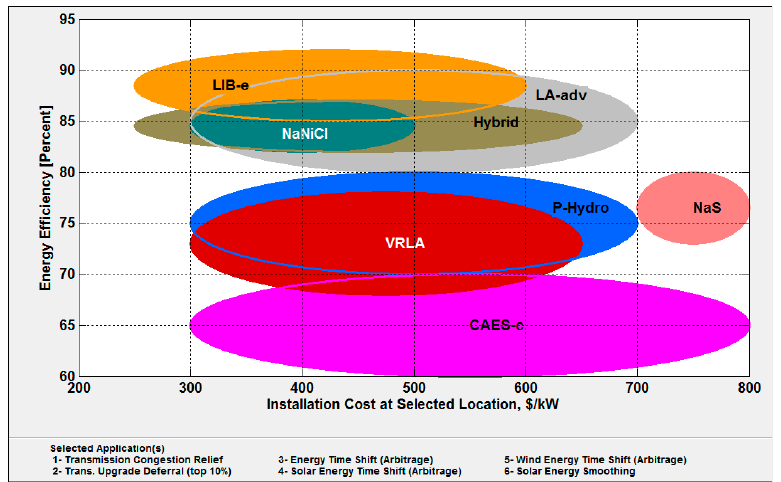
Figure 8. Energy efficiency (%) of different ESSs as a function of installation cost (USD/kW) at the selected location.